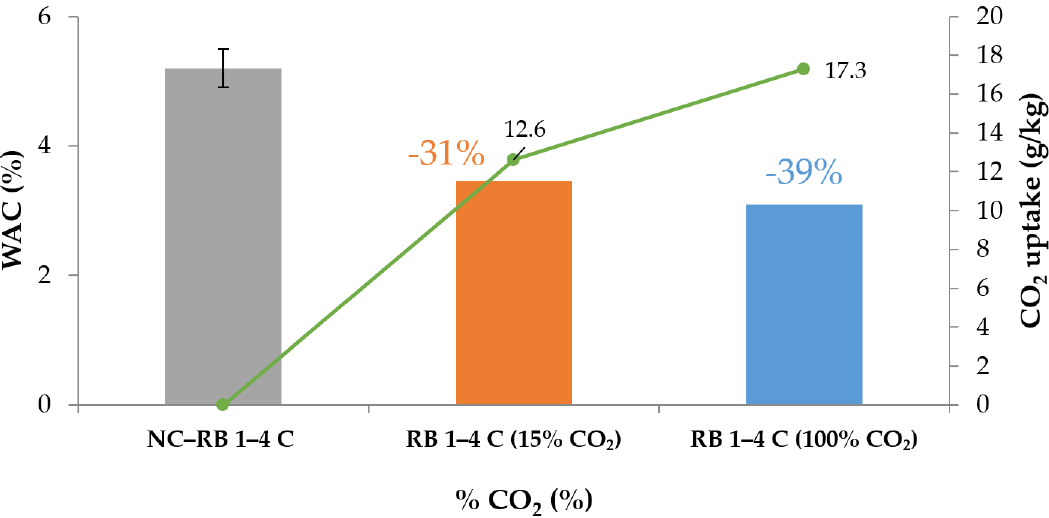
Figure 17. Effect of the CO 2 concentration on the CO 2 uptake and WAC (one WAC measurement for RCAs after carbonation).